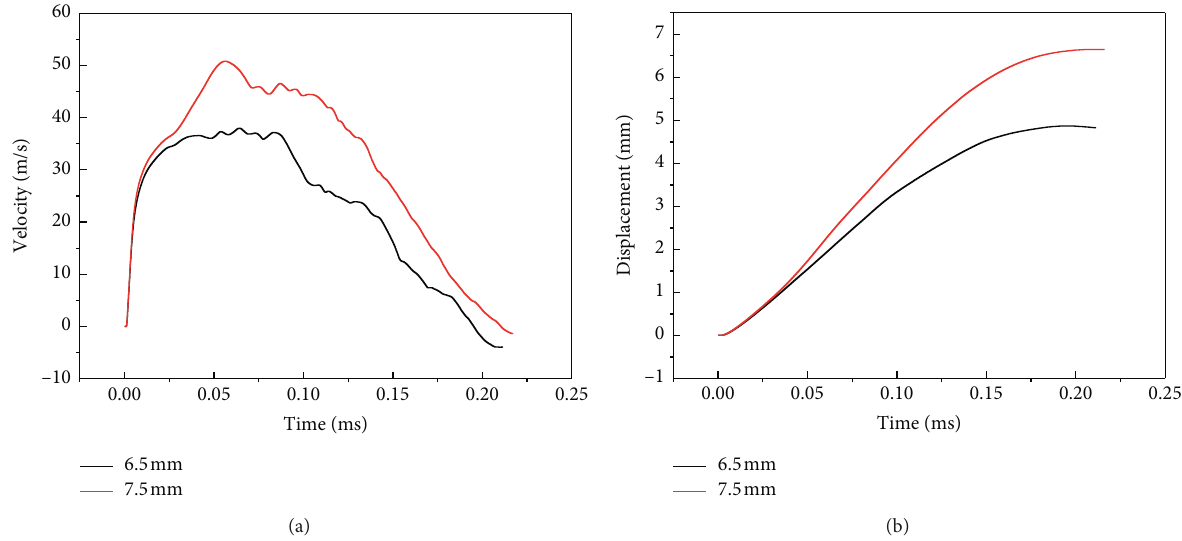
Figure 12: Cutter blade velocity and displacement, vs. time, for the spacing values of 6.5mm and 7.5mm, and for the connecting rod’s diameter of 6mm. (a) Cutter blade velocity vs. time (b) Cutter displacement vs. time.